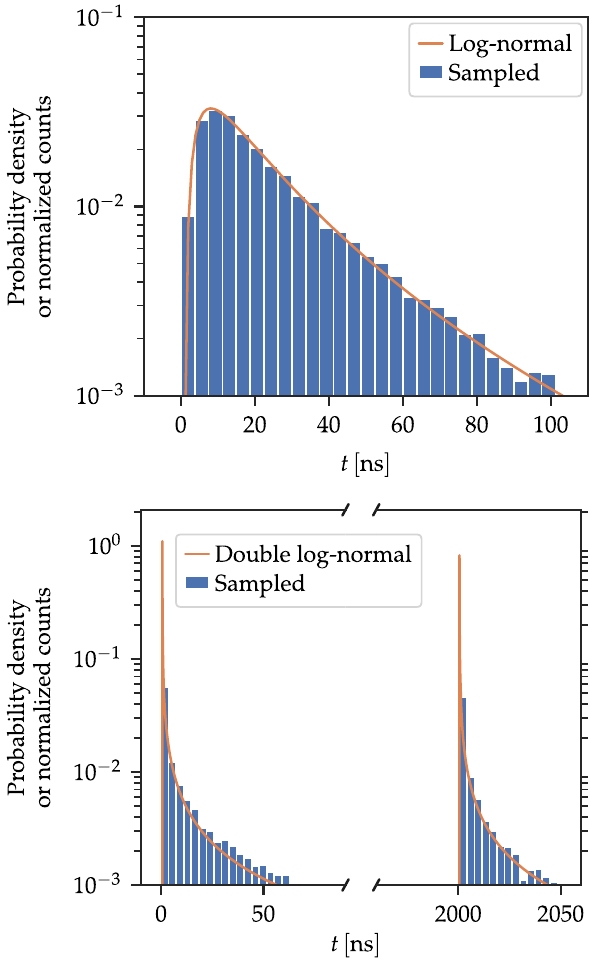
Fig. 13 Input signals used to test the strategies. On the top panel, a “wide” log-normal signal with a shape parameter σ ≈ 1, scale parameter m ≈ 3, and location parameter t 0 ≈ 0 . 6ns. On the bot- tom panel, two log-normals with the shape and scale parameters of a proton shower of log 10 ( E / eV ) = 18 . 1 and θ ≈ 30 ◦ , and location parameters t 0 , 1 ≈ 0 . 6ns and t 0 , 2 ≈ 2000 . 6ns, with the second one having an amplitude 25% smaller than the first one